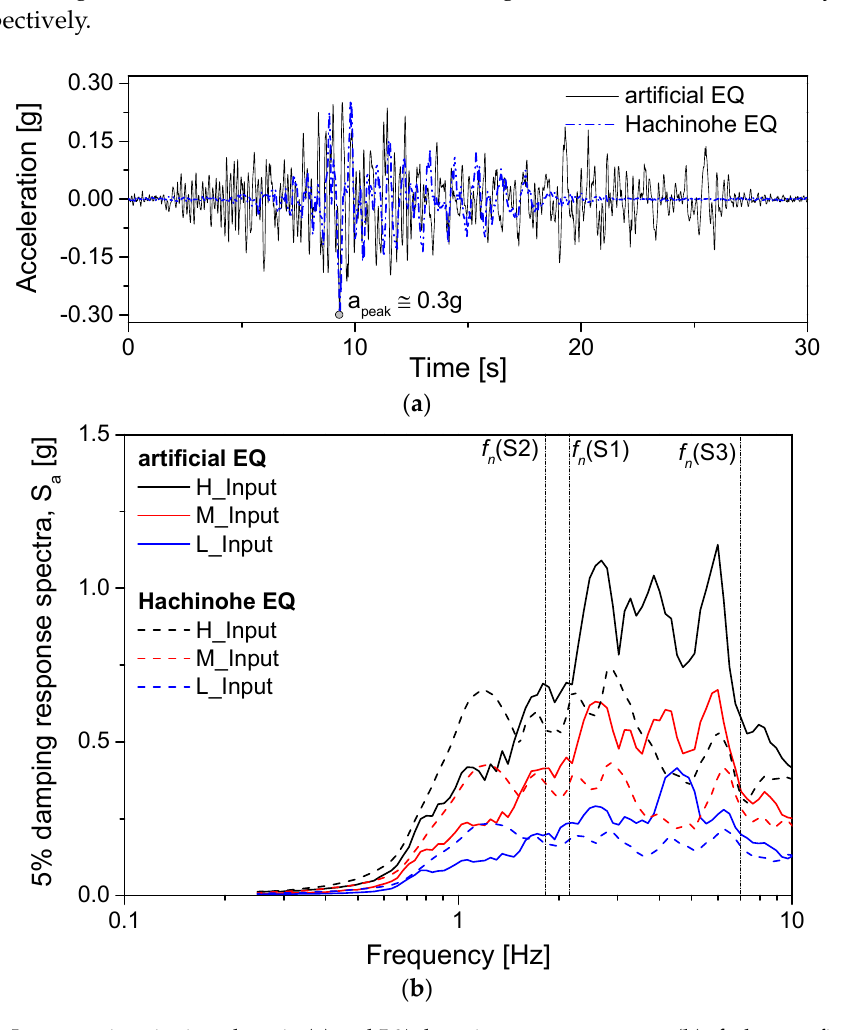
Figure 2. Shear‐wave velocity profile of prototype soil in comparison with results from Oedometer and RC (Resonant Column) tests.